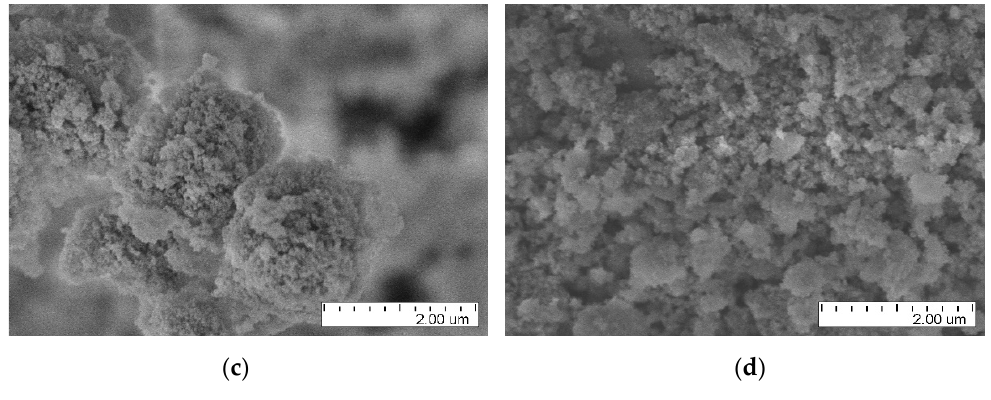
Figure 1. Examples of SEM images: ( a , b ) DF-DNDs; ( c , d ) F-DNDs. In Figure 2, one can see an image of F-DNDs measured using a TEM (FEI Tecnai G2 30 S-TWIN, NRC “Kurchatov Institute”—CRISM “Prometey”, St. Petersburg, Russia) and a corresponding distribution of DND sizes. The procedure is as described in [40].